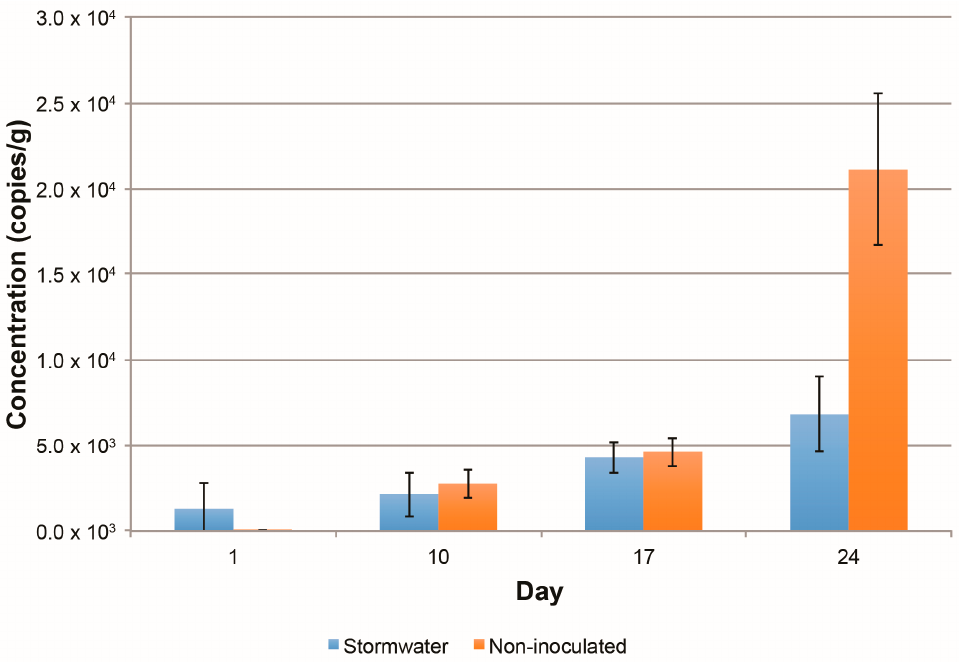
Figure 7. Total abundance of nosZ over time within non-inoculated (Neg) and environmental columns. Env-stormwater inoculated columns; Neg-Non-inoculated columns.